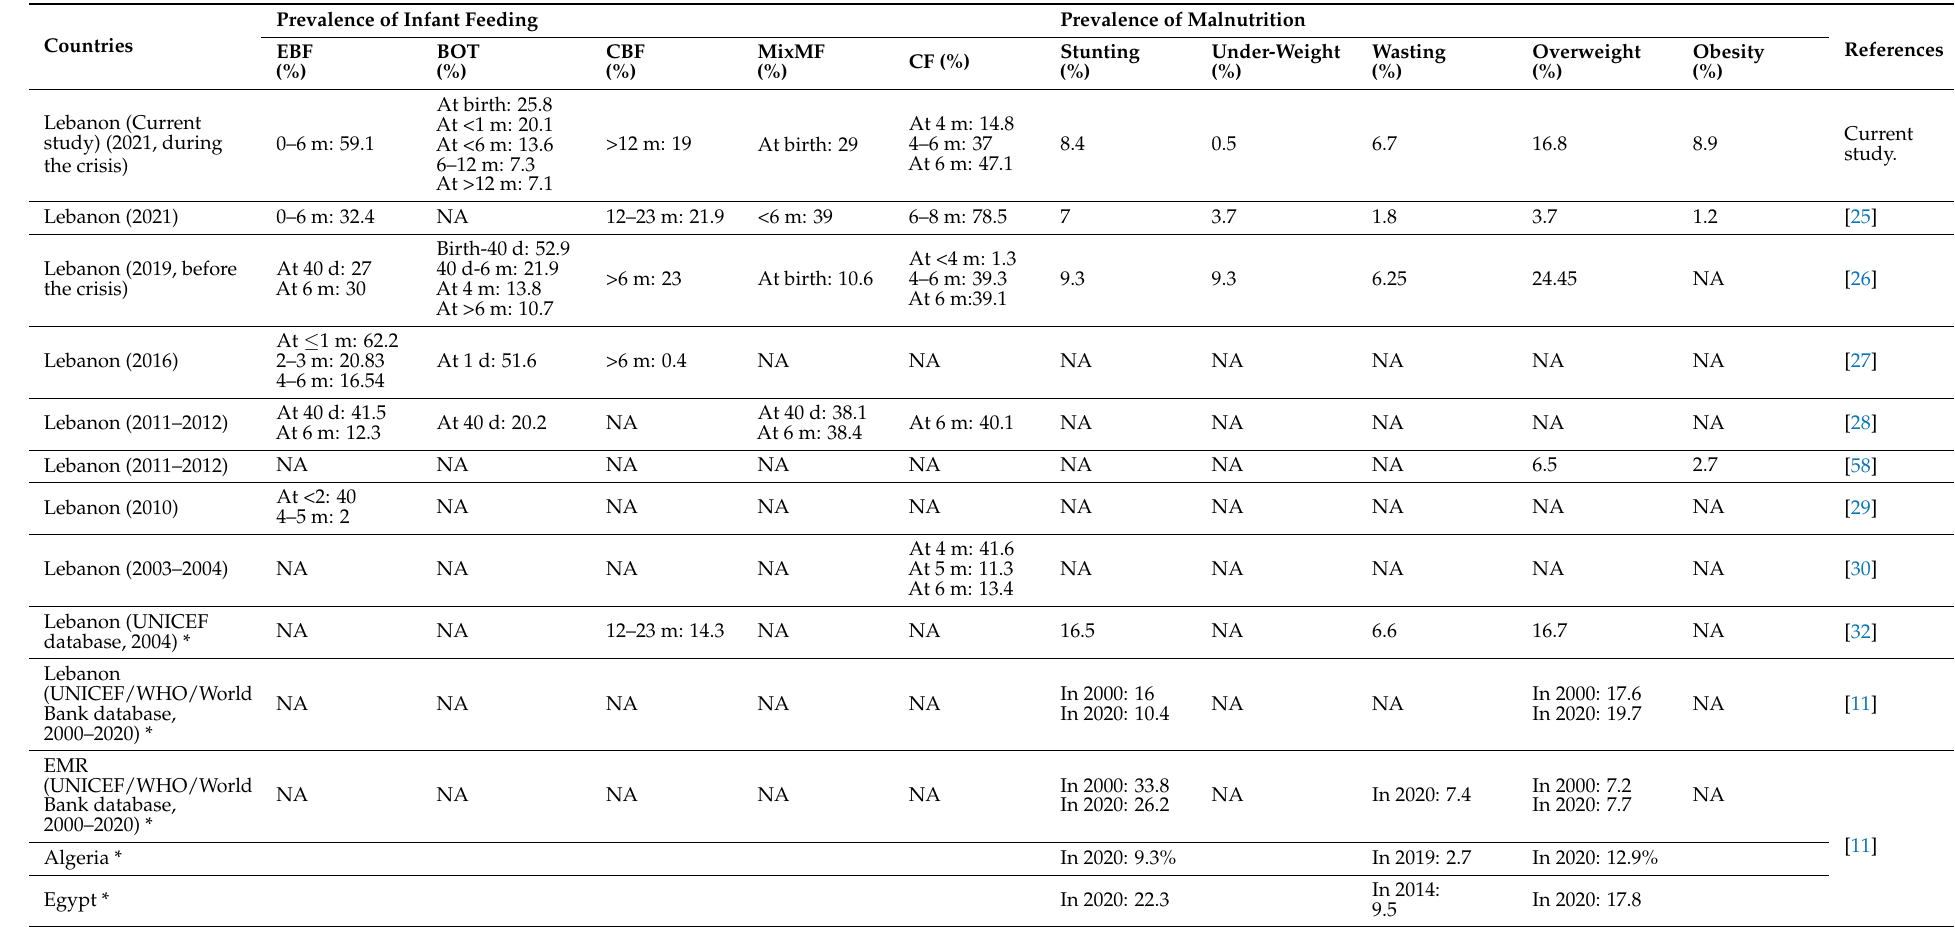
Table 6. National, regional, and global prevalence of feeding patterns and malnutrition among under 5 years children. Prevalence of Infant Feeding Prevalence of Malnutrition Countries